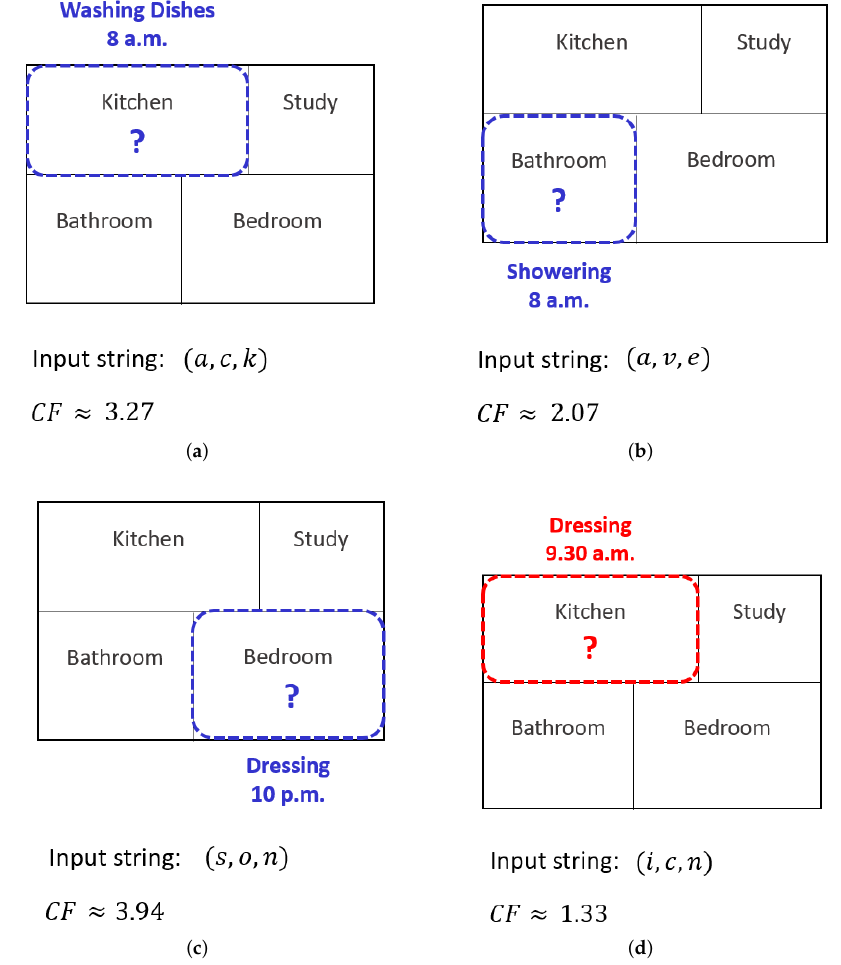
Figure 2. Illustration showing how novelty is detected by calculating the compression factor. ( a ) Sim- ilar time and location, different activity. ( b ) Similar location and activity, different time. ( c ) Similar location and activity, new time. ( d ) Similar time and activity, different location. For details, see the text.